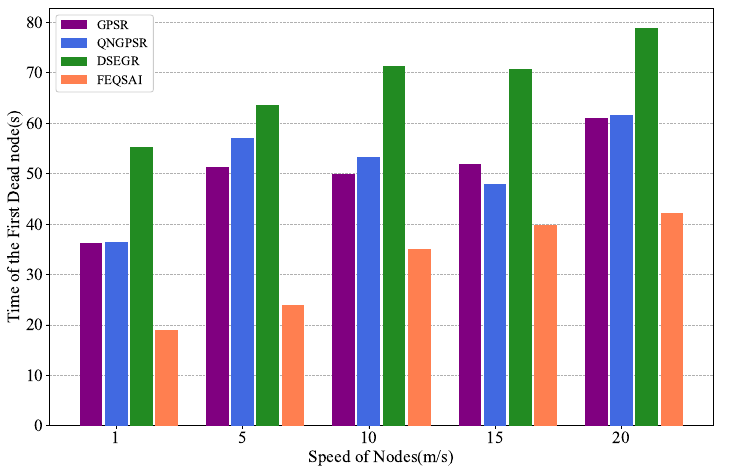
Figure 7. Performance comparison of the time of the first dead node among GPSR, QNGPSR, DSEGR, and FEQSAI with different numbers of nodes’ movement